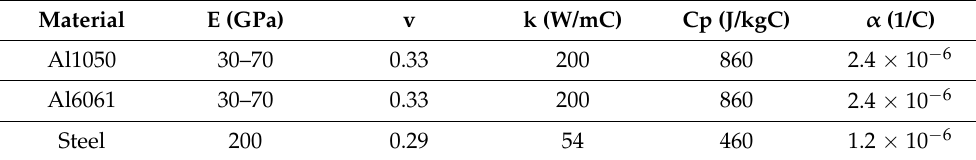
Table 4. Elastic and thermal properties used in the thermo-mechanical simulation.